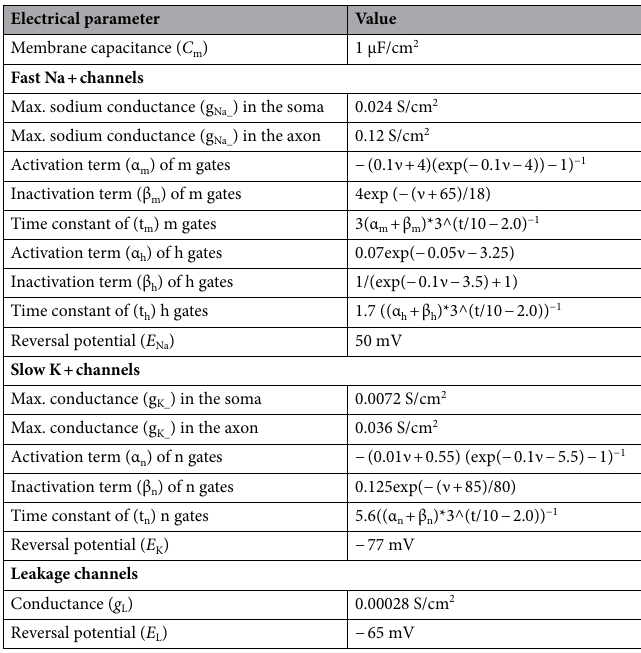
Table 2. Electric parameters of the NEURON model for an Aplysia neuron that contains a soma and an axon. t: environmental temperature in Celsius. v: membrane potential of a neural